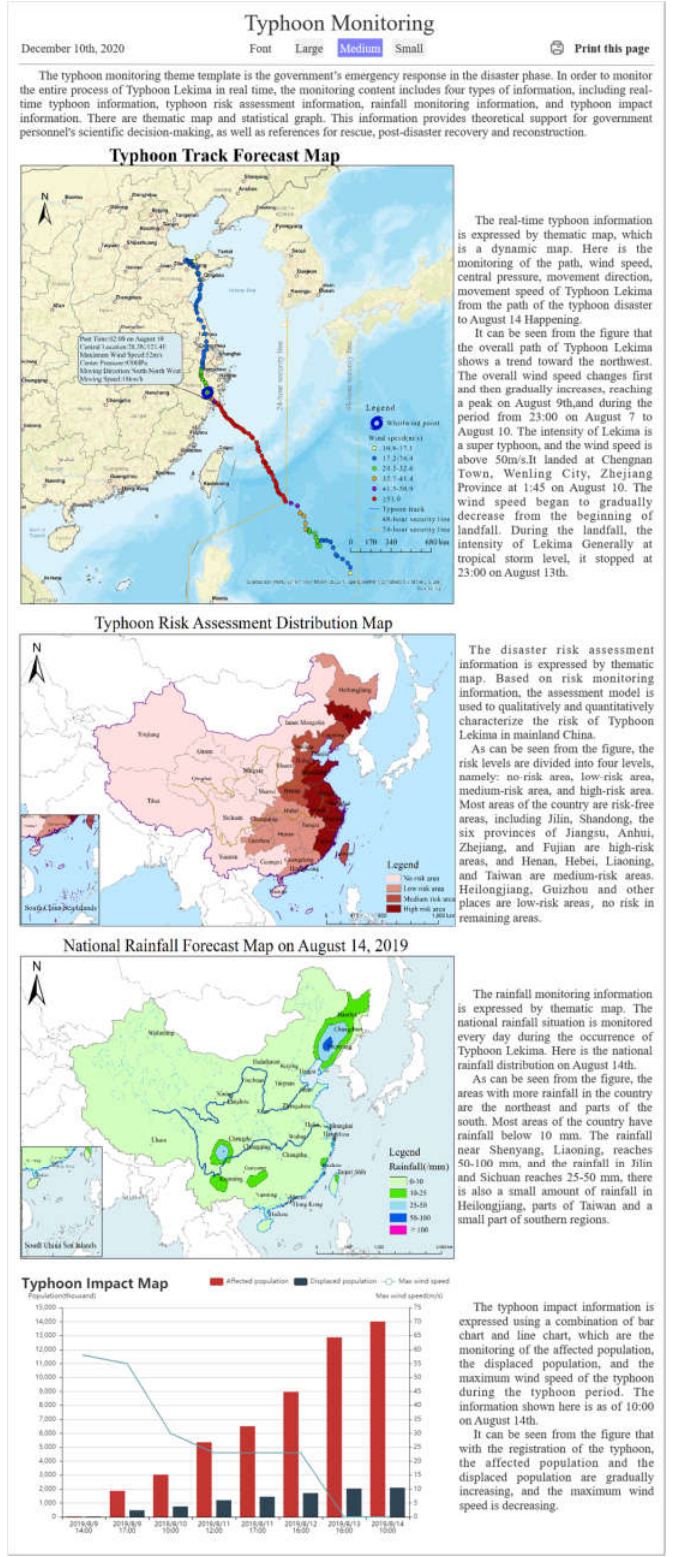
Figure 8. Government PC terminal content display map.